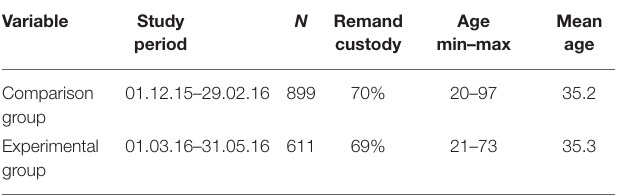
TABLE 2 | Descriptive of study